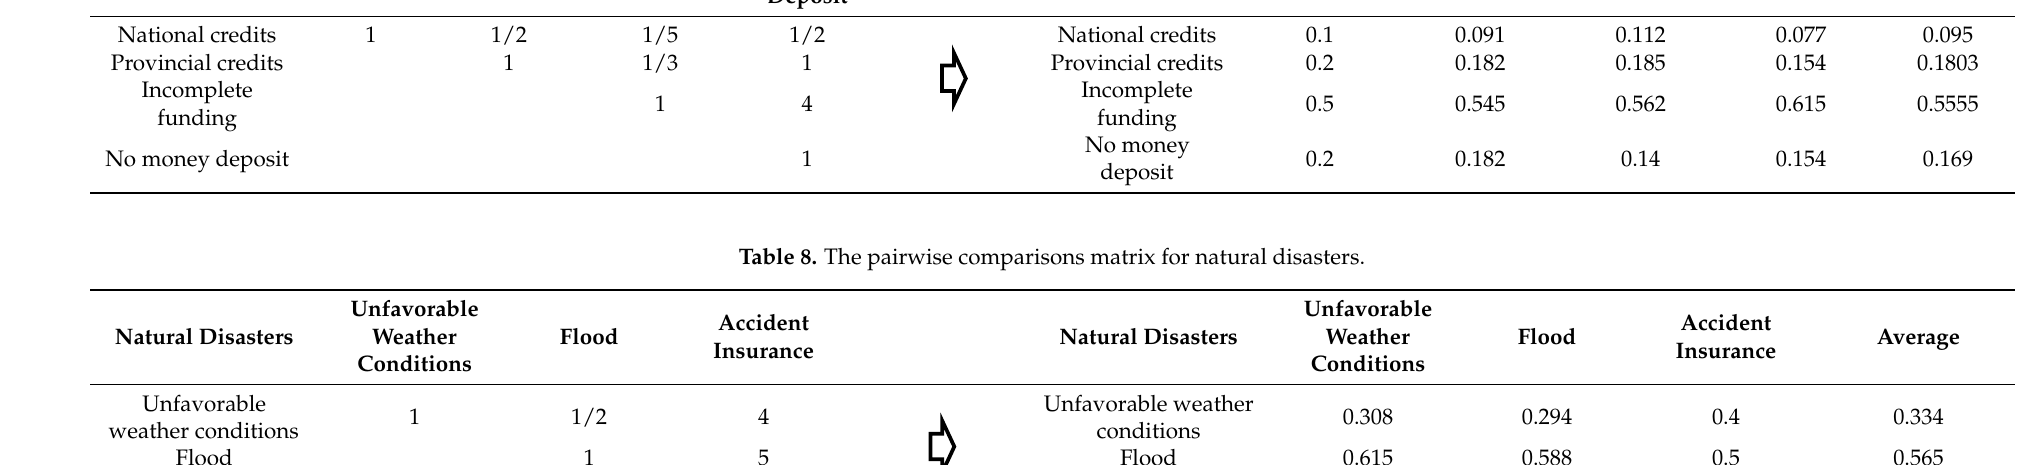
Table 5. The pairwise comparisons matrix for management